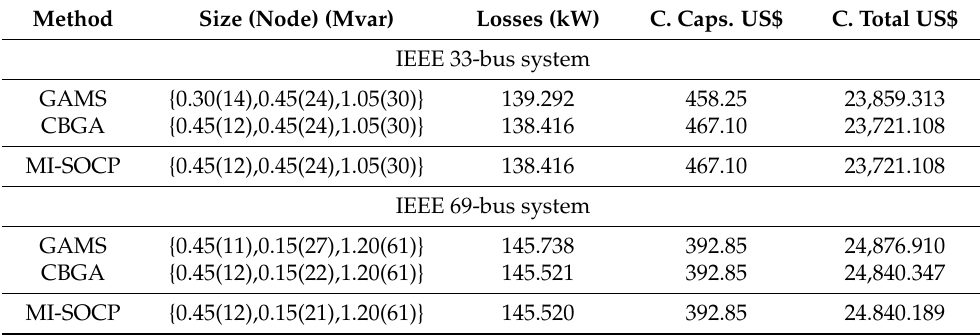
Table 6. Location, sizes, and annual operative costs for both test feeders when fixed-step capacitors are